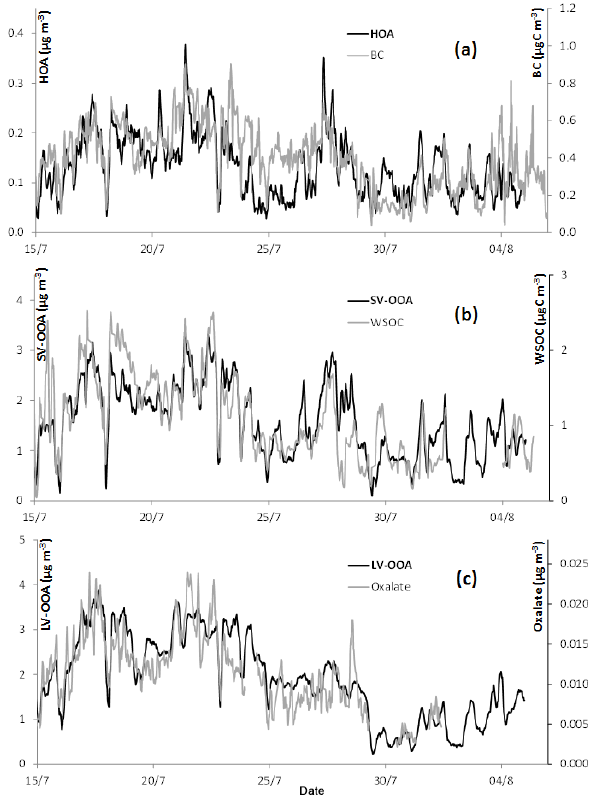
Figure 11. Time-series of (a) HOA (black) with black carbon (gray), (b) SV-OOA (black) with WSOC (gray) and (c) LV-OOA (black) with oxalate